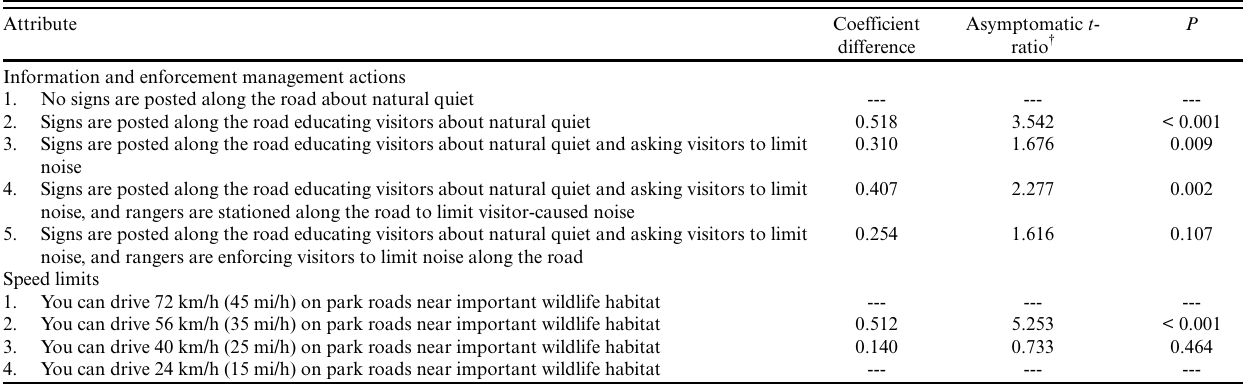
Table 1. Comparison of marginal utility coefficients between sign-absent and sign-present treatment groups.